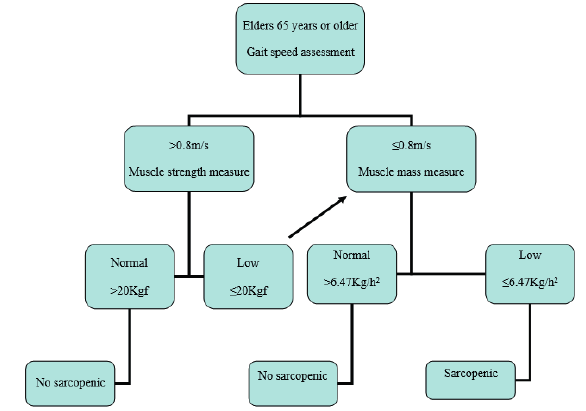
Figure 1 - EWSOP suggested algorithm for sarcopenia case find- ing in older individuals — Adapted from Cruz-Jentoft et al. [ 7 ]